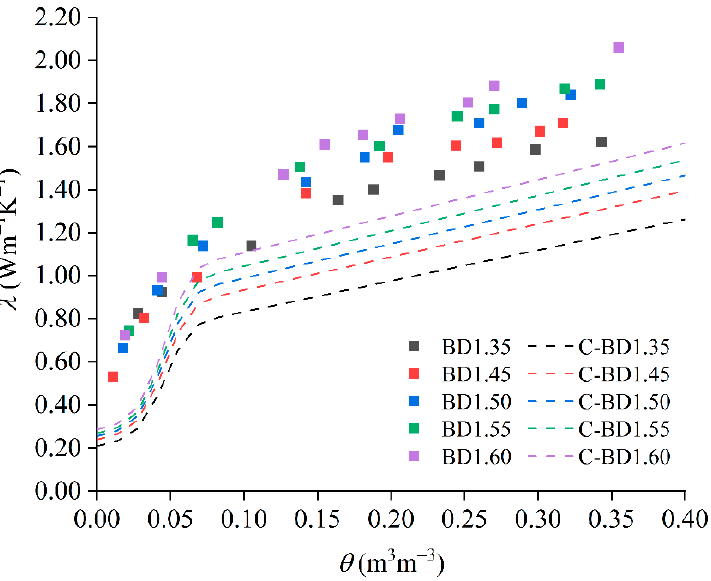
Figure 2. The measured relationship of λ ~ θ and the curves estimated by the Campbell model for soil with different bulk densities. The colored dots represent the measured values and the dotted lines represent the Campbell model curves.